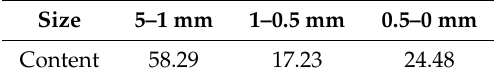
Table 4. Particle size of bituminous coal